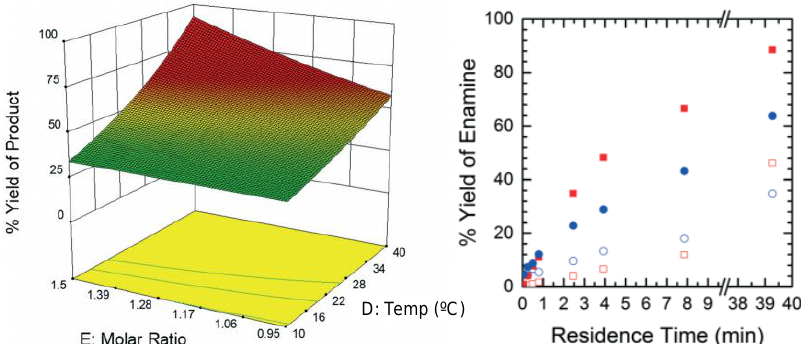
Figure 2. Design space investigation of the flow synthesis of an intermediate towards dolutegravir. Reproduced with permission from Armstrong et al., Reaction Chemistry & Engineering; published by Royal Society of Chemistry, 2019 [52].